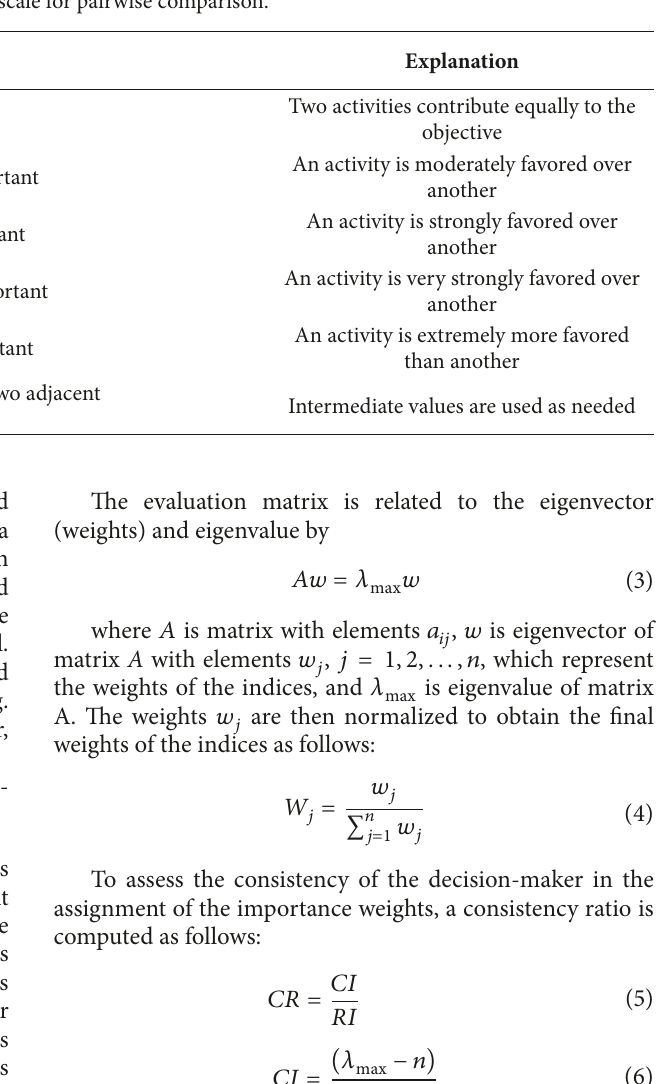
Table 1: Fundamental scale for pairwise